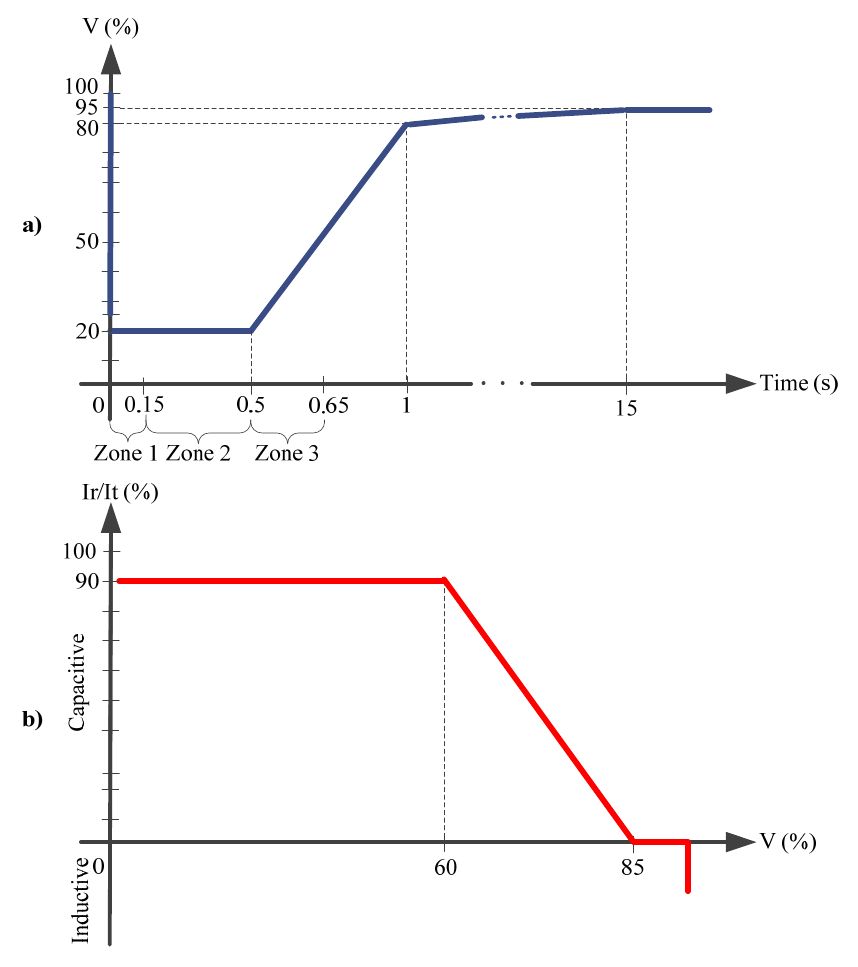
Figure 4. ( a ) LVRT profile and ( b ) reactive current response, according to the Spanish grid